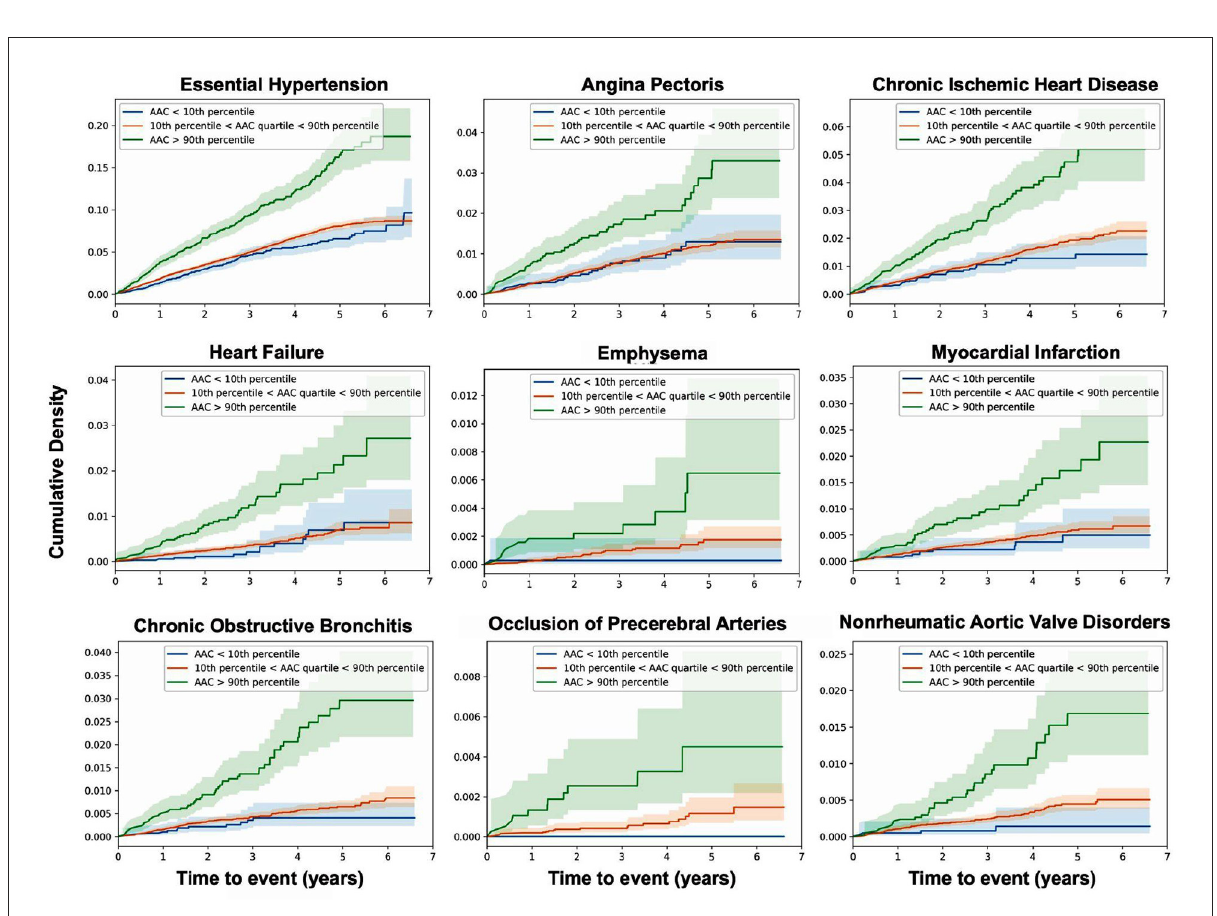
FIGURE6 AAC is a prognostic risk factor for a large class of cardiovascular and respiratory outcomes. Cumulative density plots for statistically significant ( p Bf < 0.05) AAC disease associations—post imaging visit follow-up time. Population stratified into risk groups based on AAC levels—green (highest 10%, AAC score > 3), red (lowest 10%, AAC score ∼ 0), blue (10–90% AAC). The shaded regions represent the 95% confidence interval for each subset of